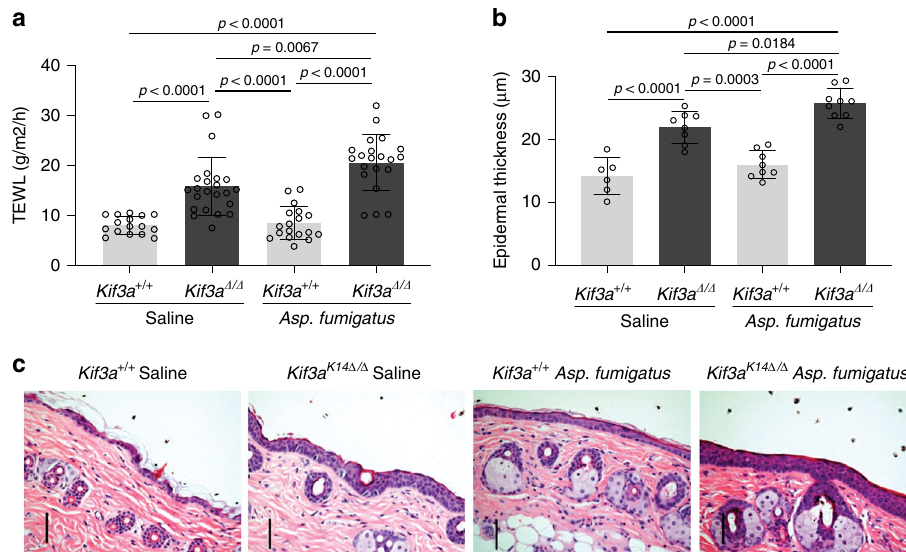
Fig. 5 Kif3a K14 Δ / Δ mice are more prone to develop AD-like phenotype following cutaneous allergen exposure. a TEWL measurement at 8 weeks of age in Kif3a + / + and Kif3a K14 Δ / Δ mice sensitized with saline control or Aspergillus fumigatus ( n = 78 biologically independent animals examined over three